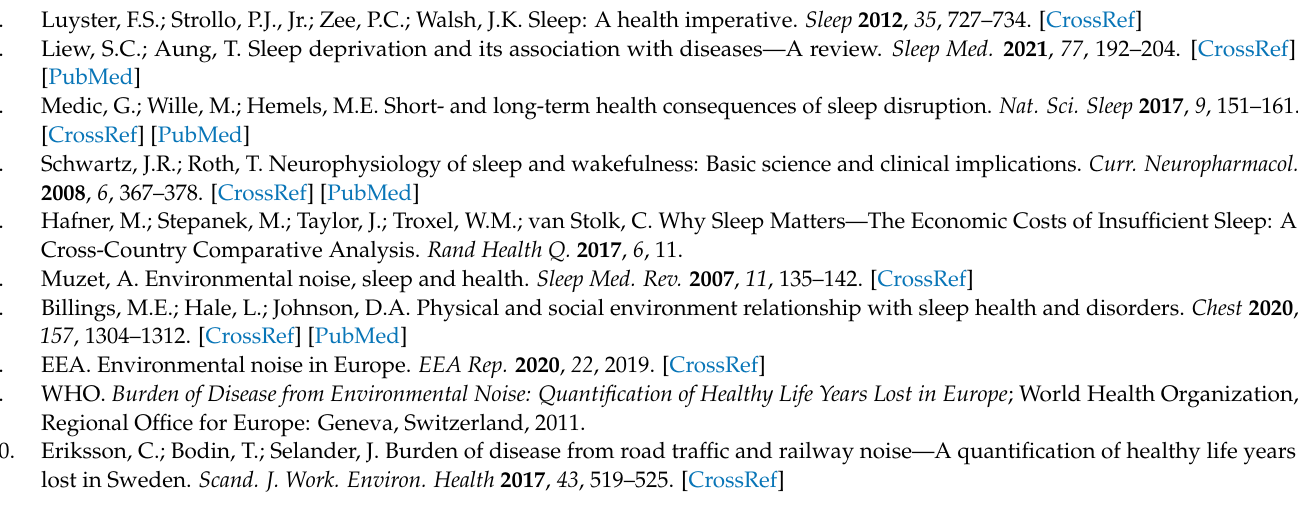
Figure S2: Comparison of HSD risk curves for rail traffic noise between the LIFE study and the WHO (Basner & McGuire 2018 [14]); Figure S3: Comparison of % highly sleep disturbed (HSD) for traffic noise between the LIFE-Adult study and the WHO review by Basner & McGuire 2018 [14], using predictions from the univariate logistic regression